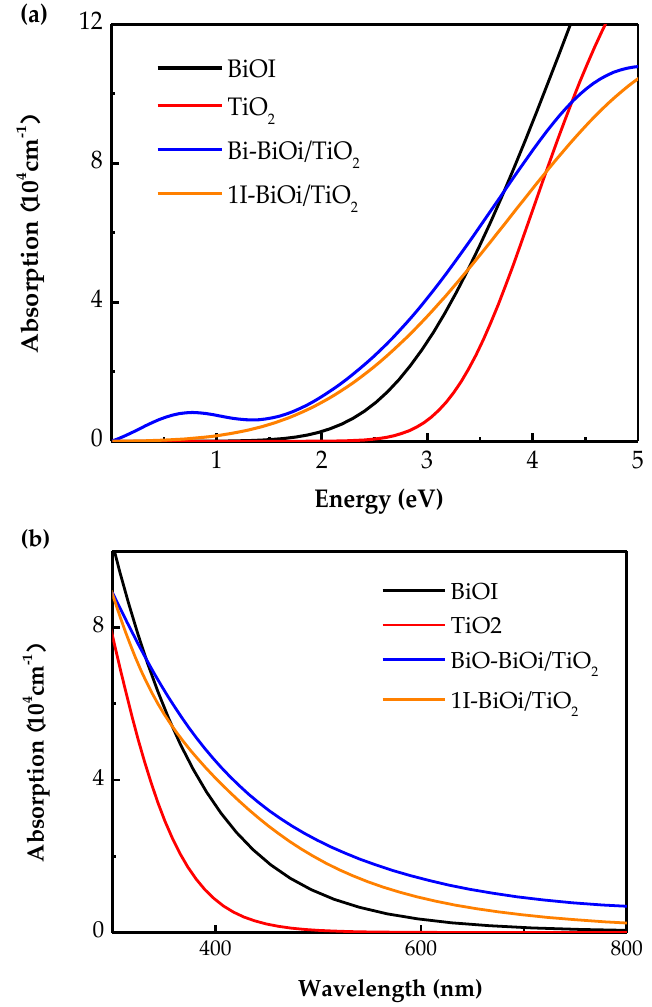
Figure 7. The absorption spectra of pure BiOI, TiO 2 , and BiOI/TiO 2 heterojunction as the function of ( a ) energy and ( b ) wavelength using the DFT method.